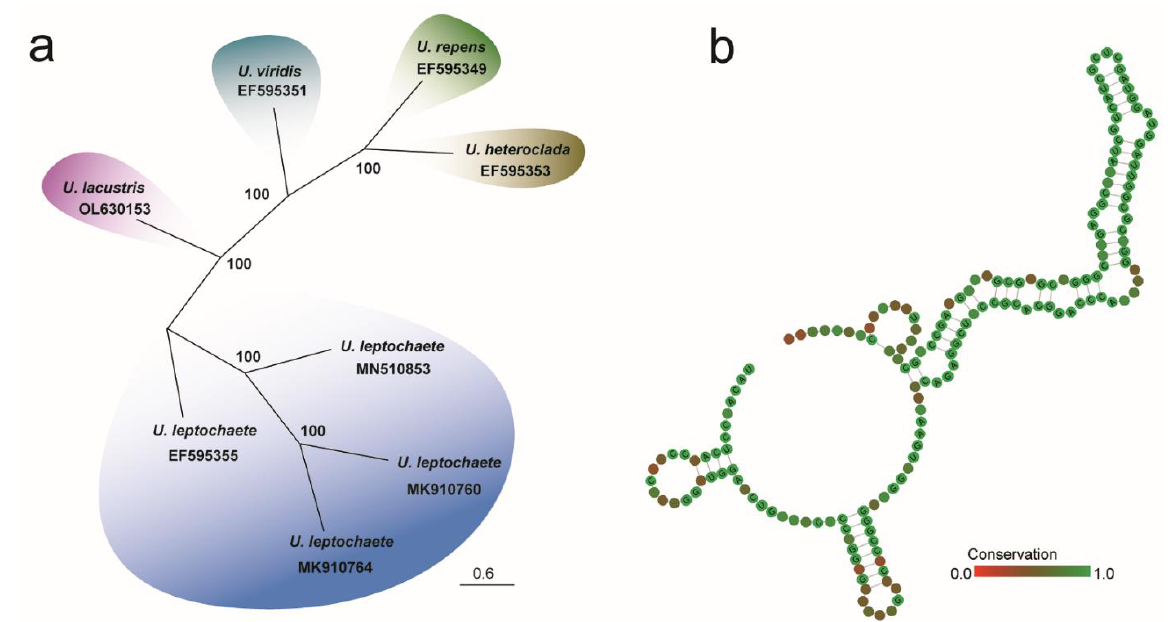
Figure 6. ( a ). The phylogenetic tree reconstructed from ITS2 secondary structure and sequence. Maximum likelihood bootstrap values are given on nodes. Different species are circled with different colors as the background. ( b ). The ITS2 secondary structure among 8 strains in Ulvella . The darker the color, the more significant the variation. Table 3. CBCs and h-CBCs quantities with 8 algal sequences.